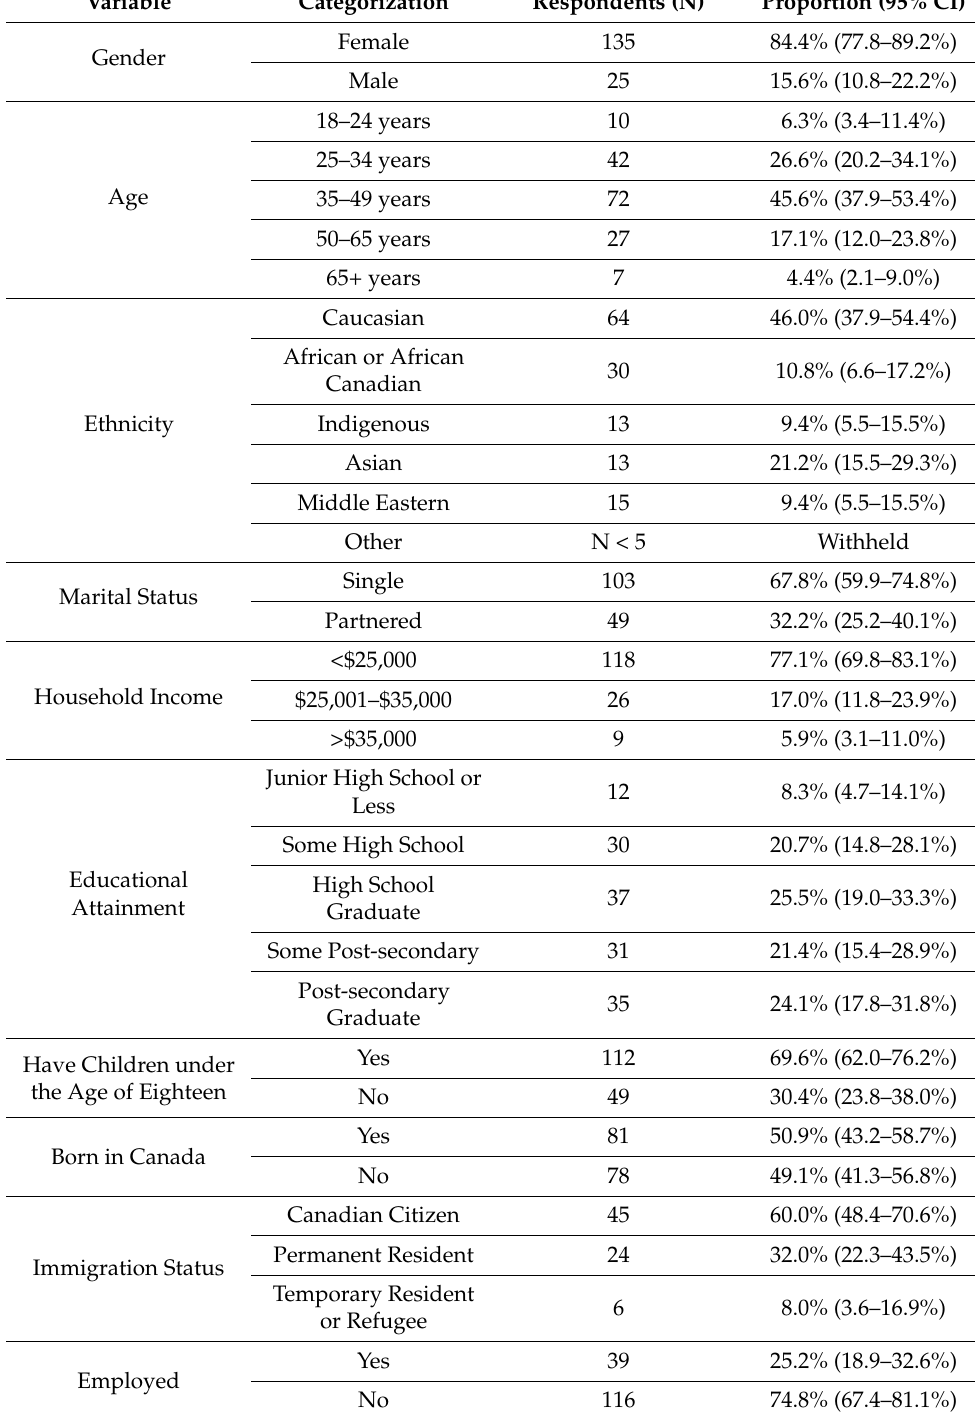
Table 1. Demographic characteristics of study